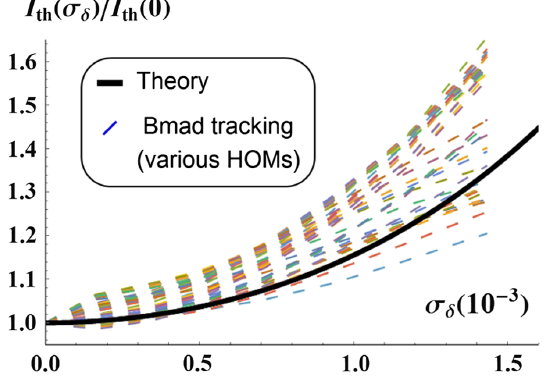
FIG. 24. Fifty I results from tracking a beam (3000 particles th per bunch) through the CBETA 1-pass lattice with different σ δ and HOM assignments. Each of the 50 dashed curves corre- sponds to one specific HOM assignment, and the thick curve is the theory prediction with a Gaussian